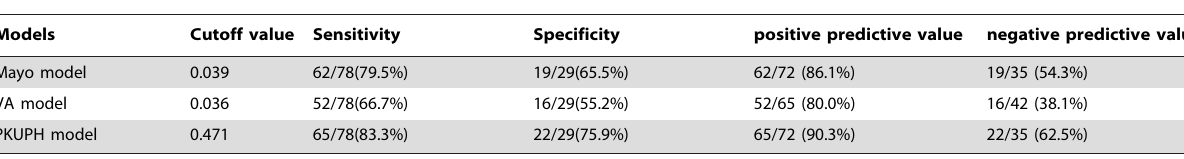
Table 7. Comparison of predicting performance between different models.